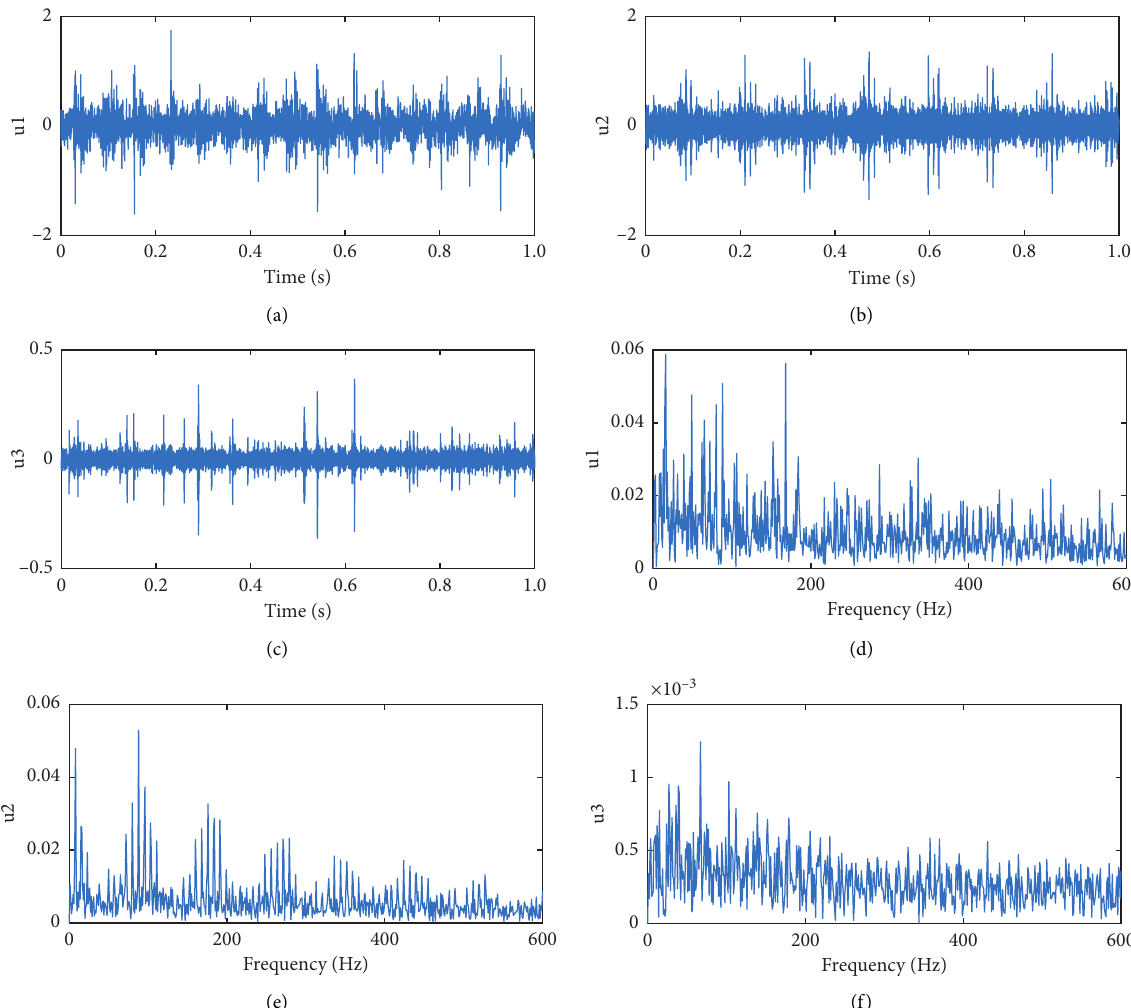
Figure 27: Experimental signals of case 2: signal processing results based on IPAVMD: (a–c) time-domain waveform of each mode and (d–f) the corresponding squared envelope